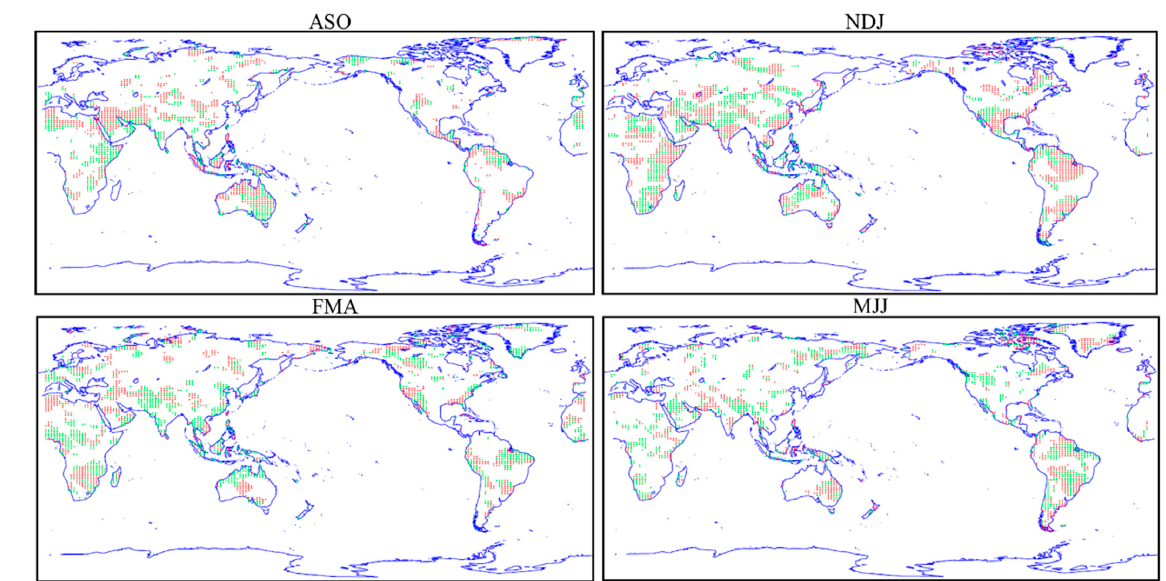
Figure 2. Rainfall simulated from multi-model sea surface temperature (SST)—seasonal rainfall forecasts with respect to rainfall simulated from POAMA SST (POM-Rain) over the grid cells where at least one of the observed SST anomaly (SSTA) indices has significant correlation at 95% confidence interval (>|0.39|) with the observed rainfall. Green- and red-shaded grid cells symbolize improvement and non-improvement by multi-model SST (MM-Rain), respectively [77]. The acronyms ASO, NDJ, FMA and MJJ represent the four seasonal variations. ASO—August, September, October; NDJ—